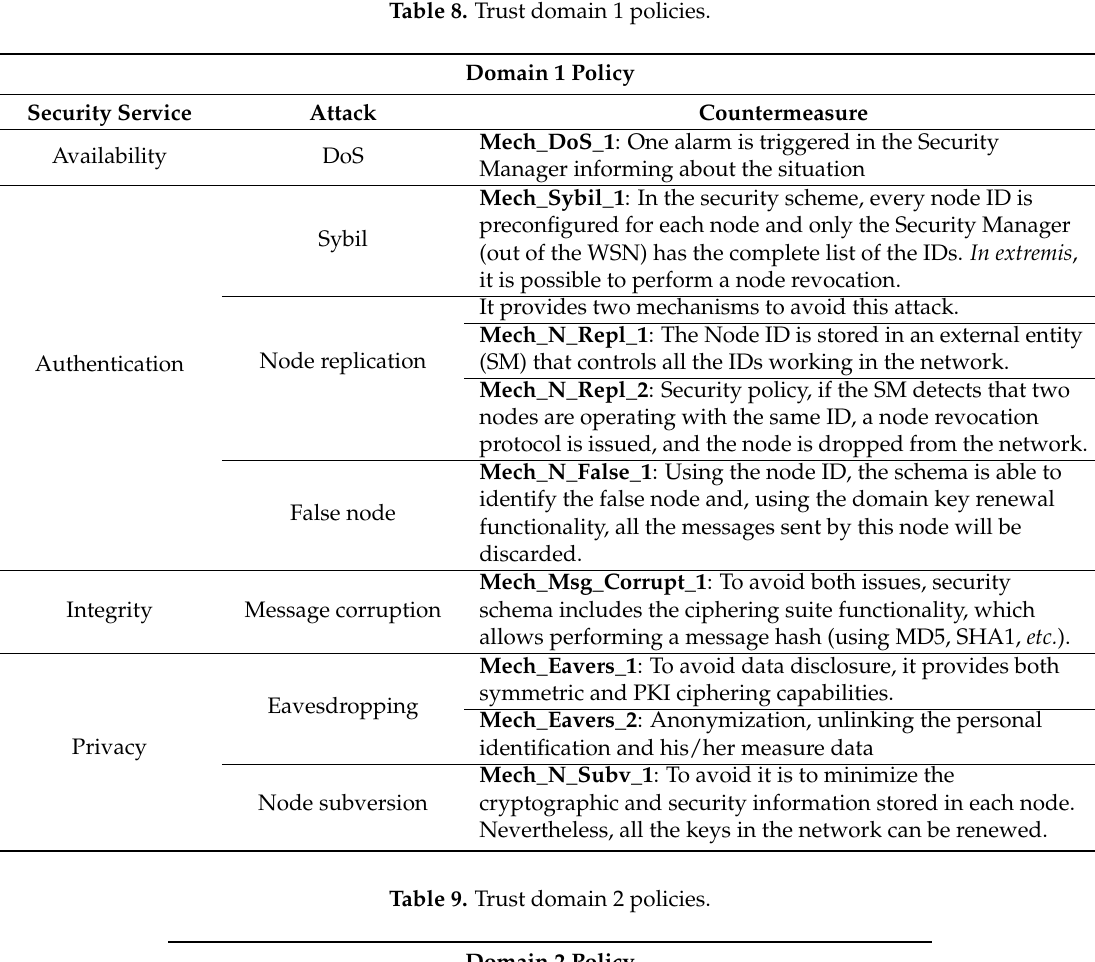
Table 8. Trust domain 1 policies.